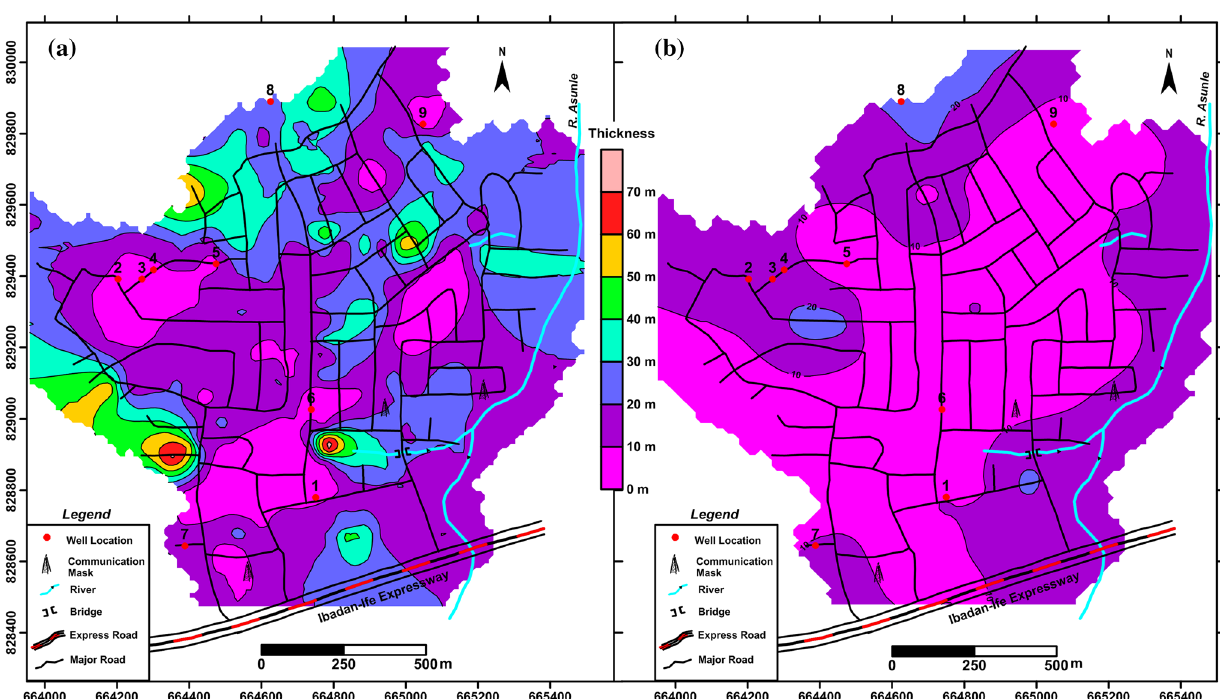
Fig. 14 Overburden thickness maps derived from a 2D magnetic models and b 1D VES interpretation